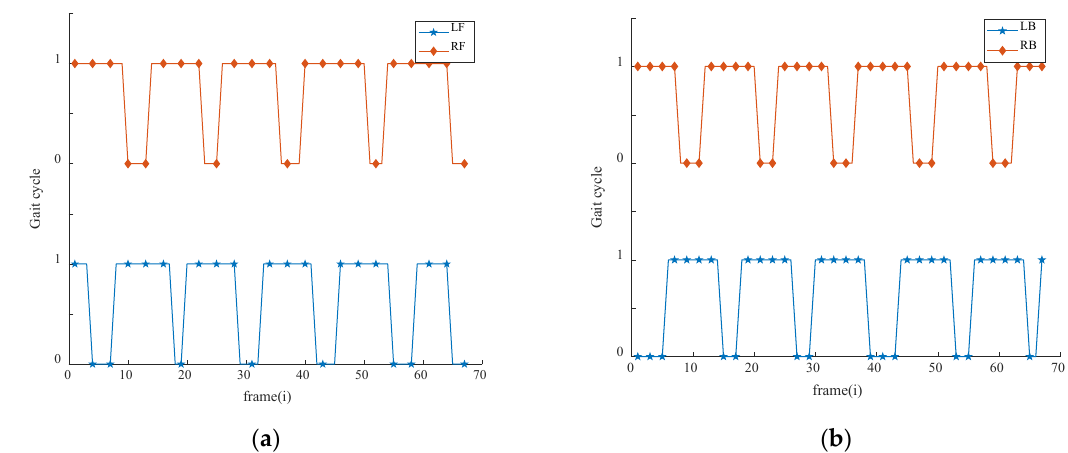
Figure 19. ( a ) Horse’s gait cycle of LF, RF leg; ( b ) horse’s gait cycle of LB, RB leg.